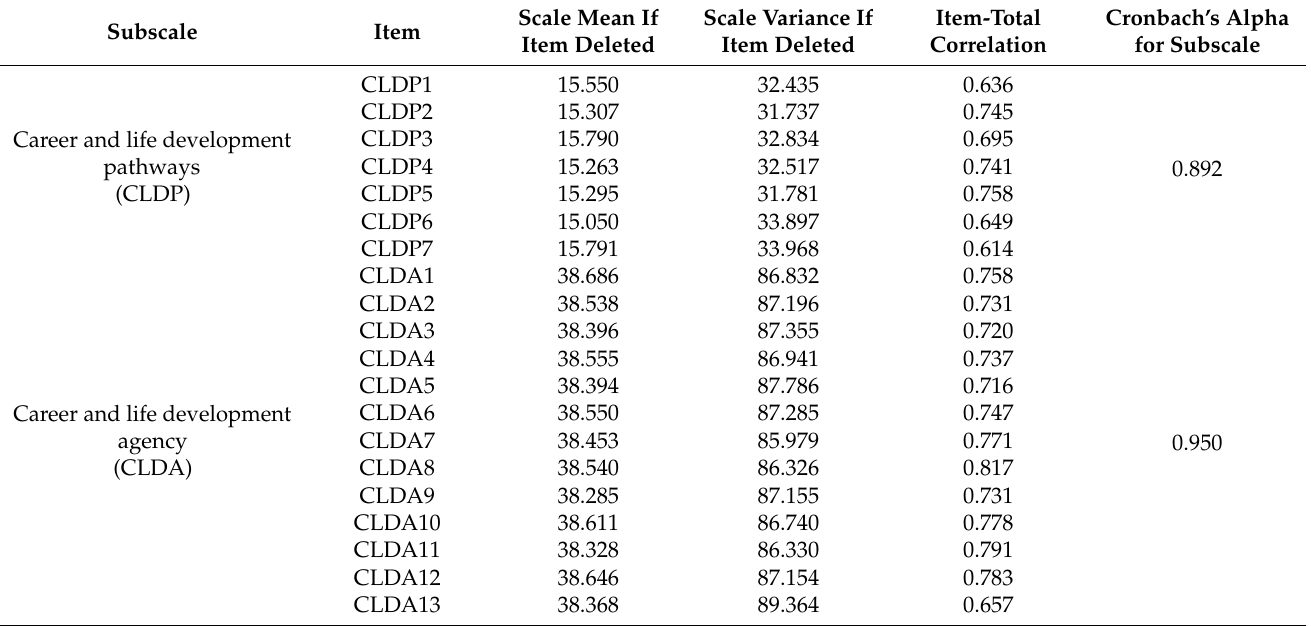
Table 2. Scale statistics and item total correlations for the career and life development hope (CLDH) scale.